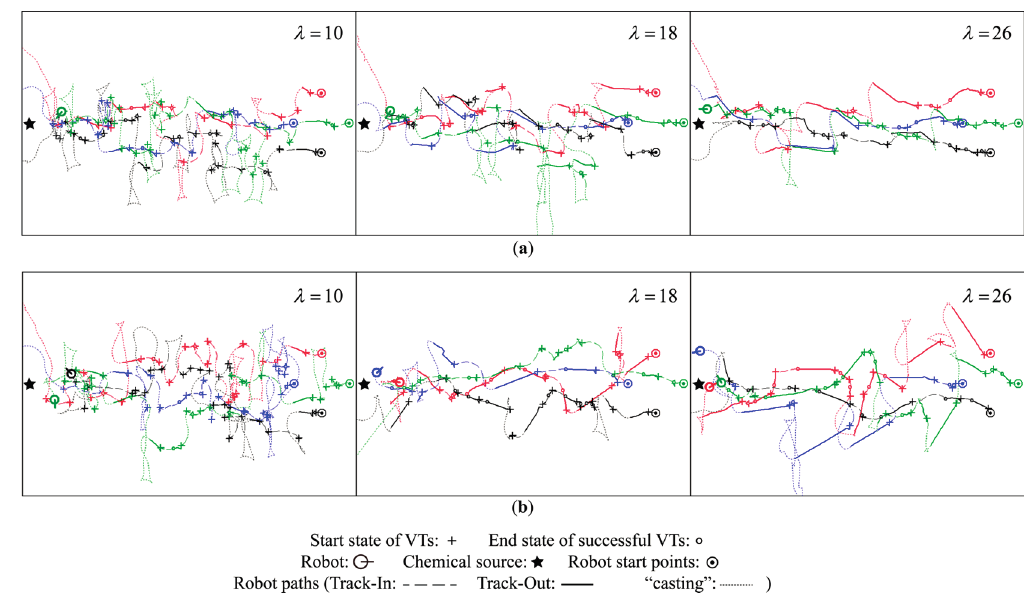
Figure 9. Comparison of the robot trajectories obtained by setting different values of λ .